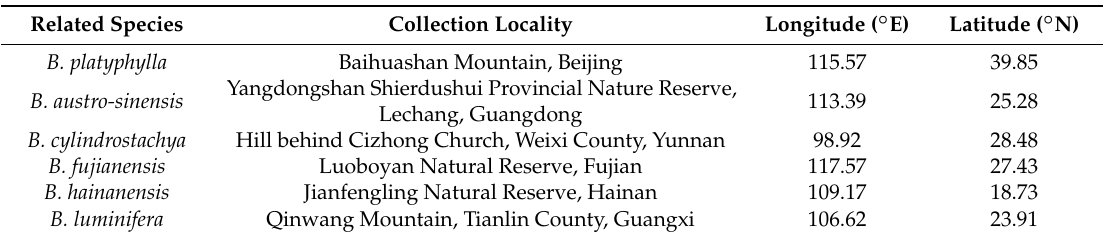
Table 2. List of six Betula species in China used for cross-species transferability of developed SSR